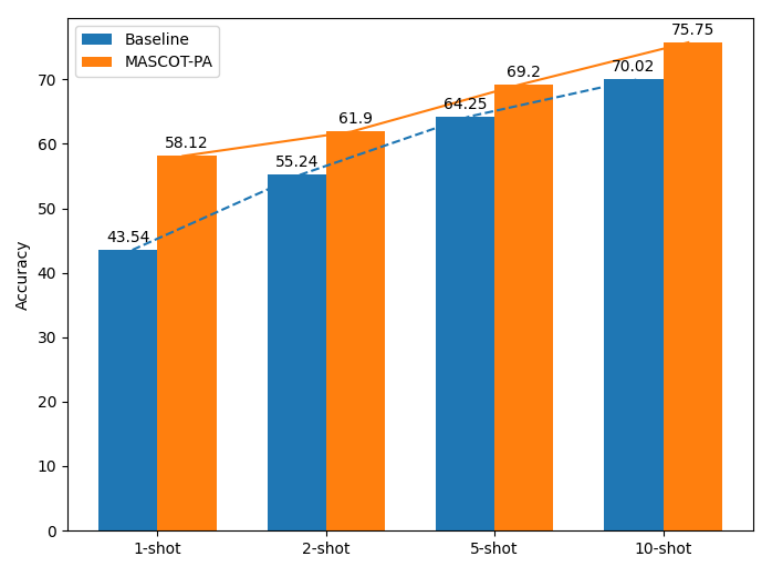
Figure 6. ShihChi document 5-way- K -shot relation extraction performance.